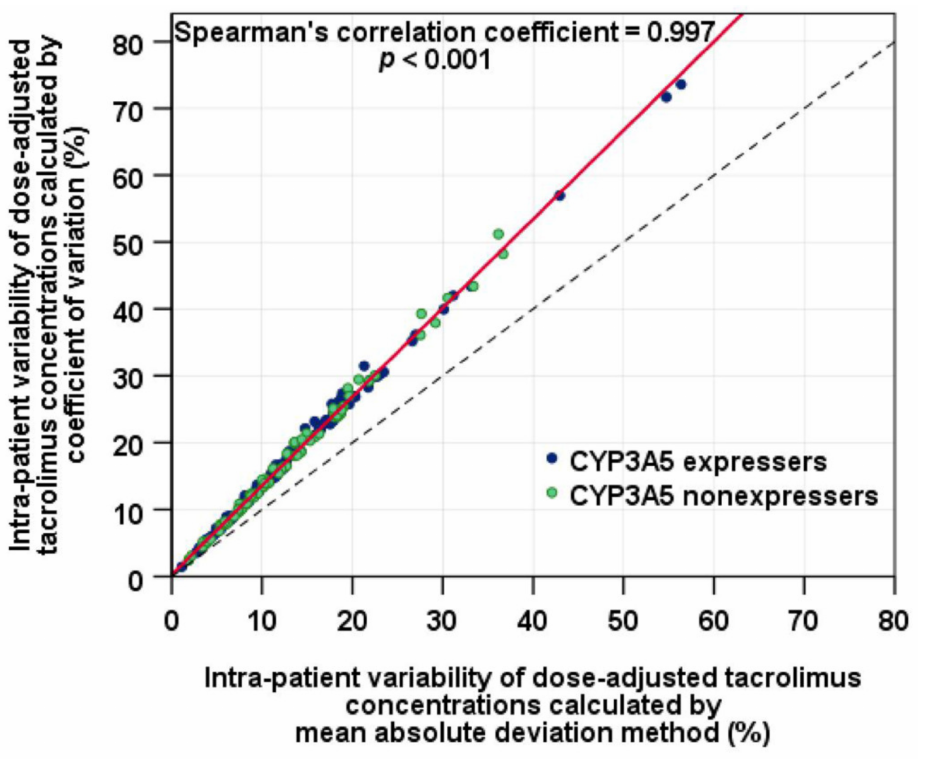
Figure 2. Correlation of intra-patient variability of tacrolimus dose-adjusted trough concentrations estimated by coefficient of variation and intra-patient variability of tacrolimus dose-adjusted trough concentrations estimated by mean absolute deviation method (the solid line is the regression line; the dashed line represents the line of